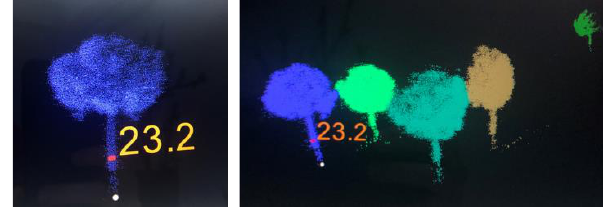
Figure 9. Example of some automatically segmented individual tree (each color represent individuality) and determining lowest position on bottom of an individual